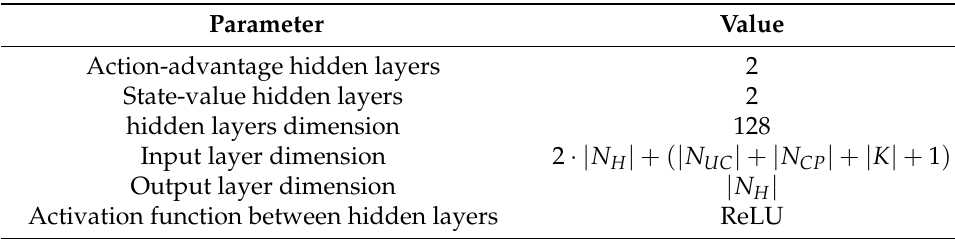
Figure 2. Dueling-architectured DDQN topology for our SFC Deployment agent: A two-stream deep neural network. One stream approximates the state-value function, and the other approximates the action advantage function. These values are combined to get the state-action value estimation in the output layer. The inputs are instead the action is taken and the current state. Table 2. Deep ANN Assigner topology